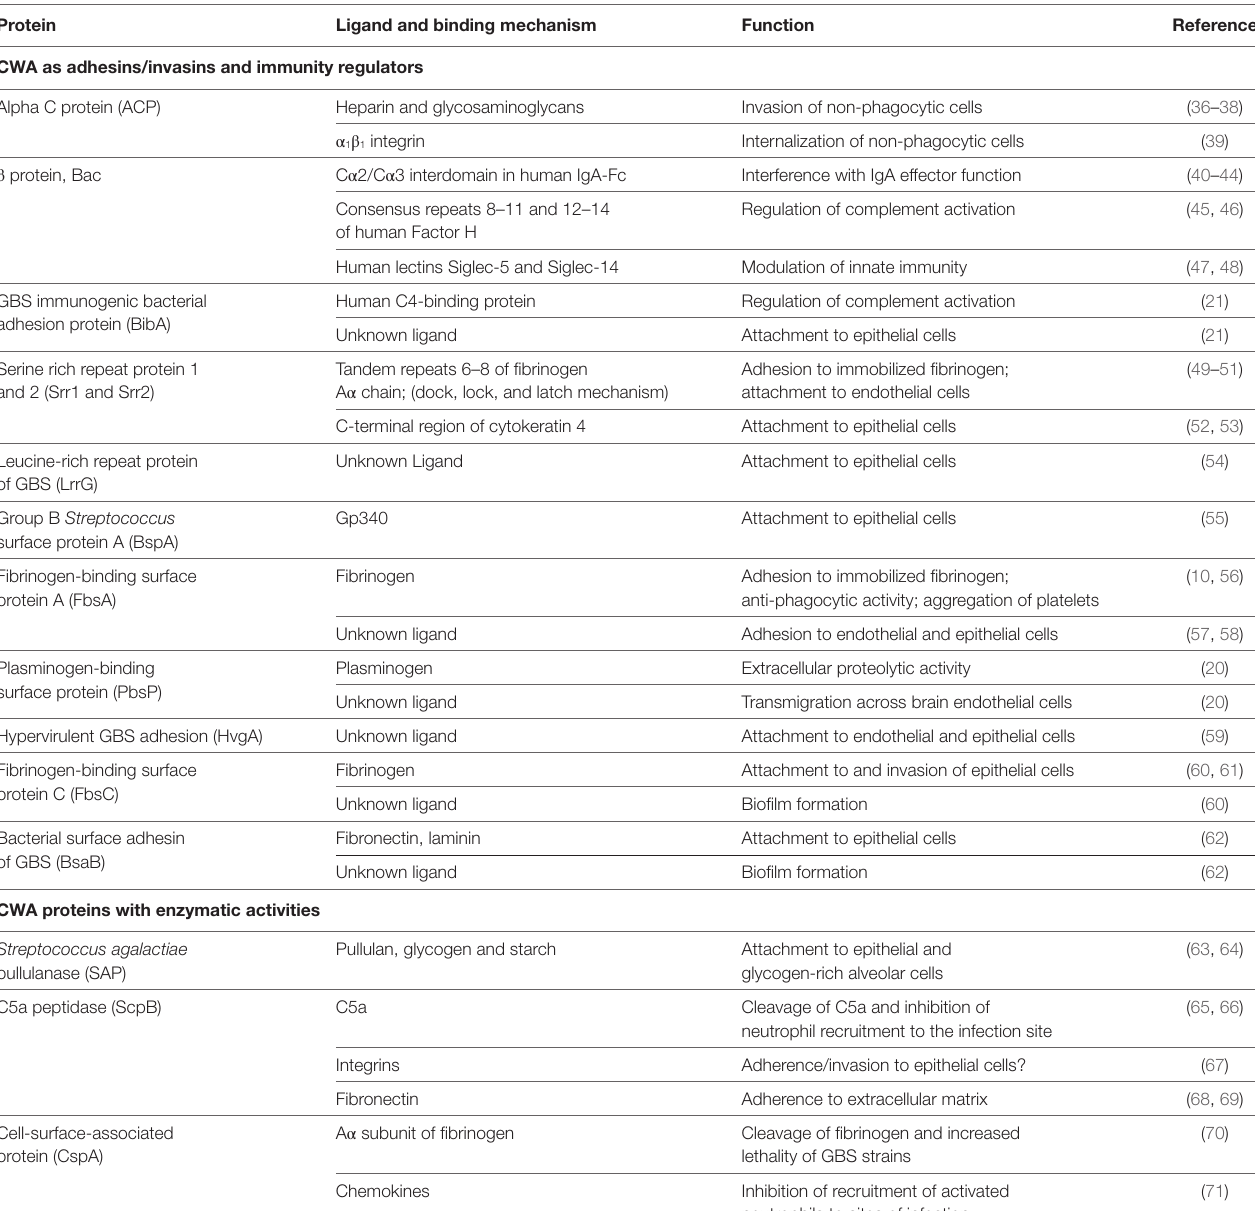
TABLe 1 | The main known CWA proteins of S.